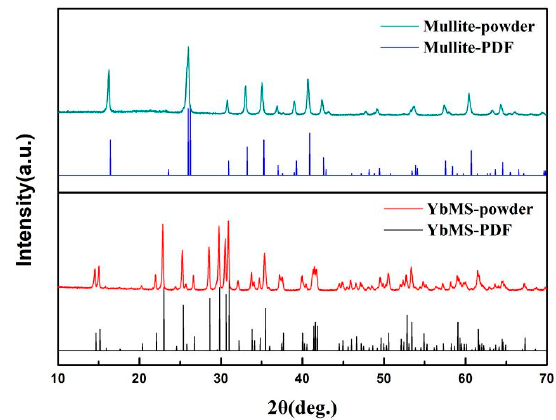
Figure 1. XRD patterns of the starting powders.